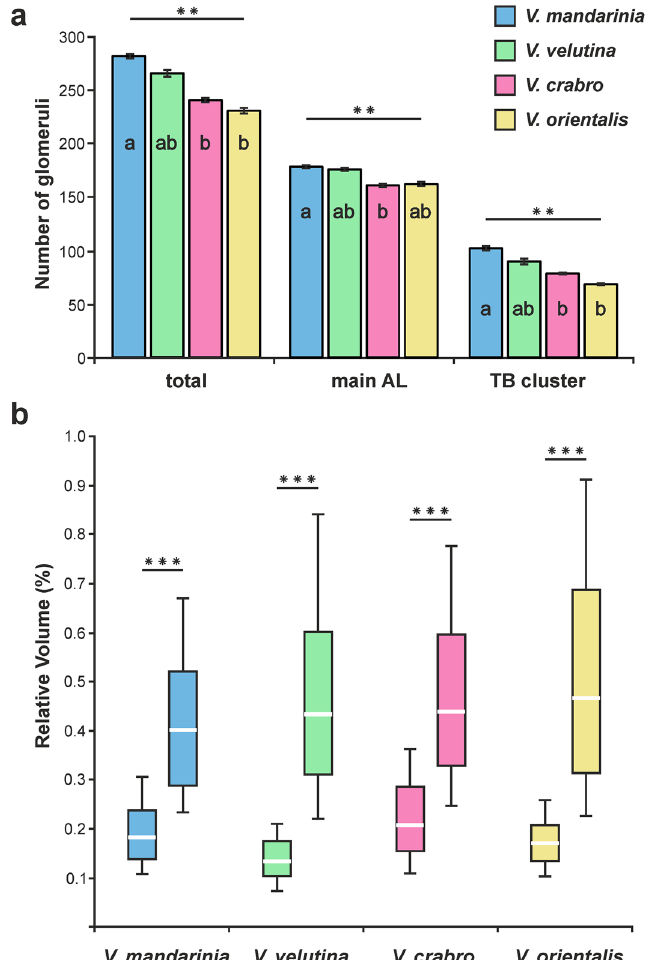
Figure 3. Number and volume of olfactory glomeruli in four hornet species. ( a ) Number of glomeruli in the whole antennal lobe (total) or its two main compartments (main AL and T B cluster) in V. mandarinia (blue), V. velutina (green), V. crabro (pink) and V. orientalis (yellow). Significant differences are found within both compartments (Kruskal–Wallis test, ** p < 0.01). Different letters indicate significant differences in post hoc Dunn tests ( p < 0.05). ( b ) Box plots showing the relative volume of the T B glomeruli (left box) compared to glomeruli of the main AL (right box) for each of the four hornet species. In all cases, T B glomeruli are smaller than other glomeruli.